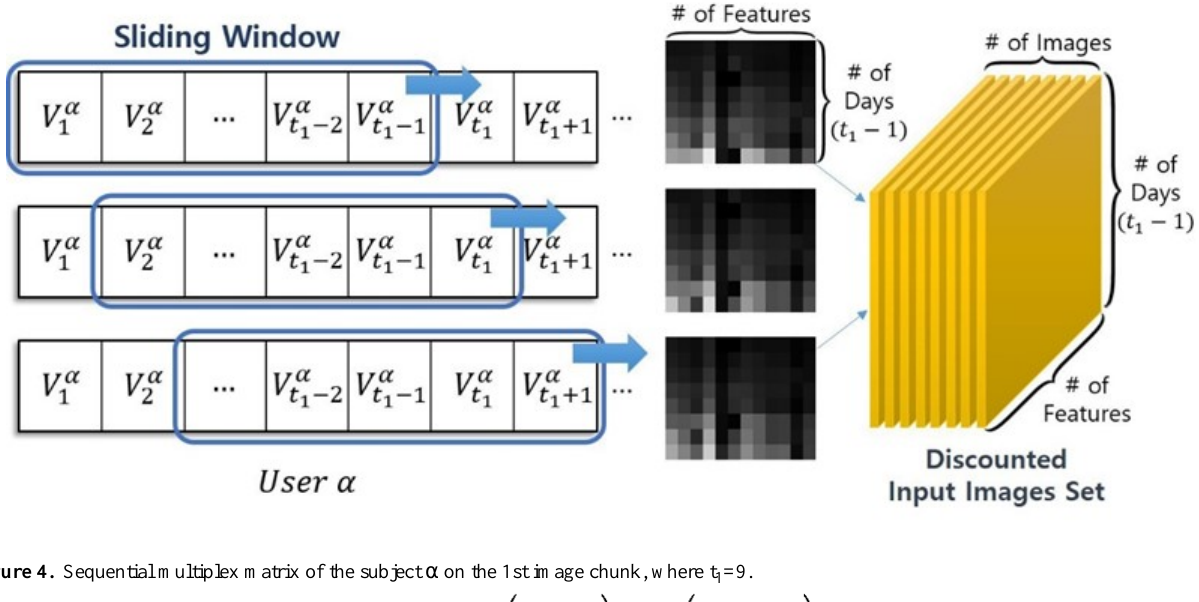
Figure 3. Converting the consecutive sleep and activity data to images: sliding windows of 8-day chunks (# of Features=12, # of Days [ie, win-size]=8).